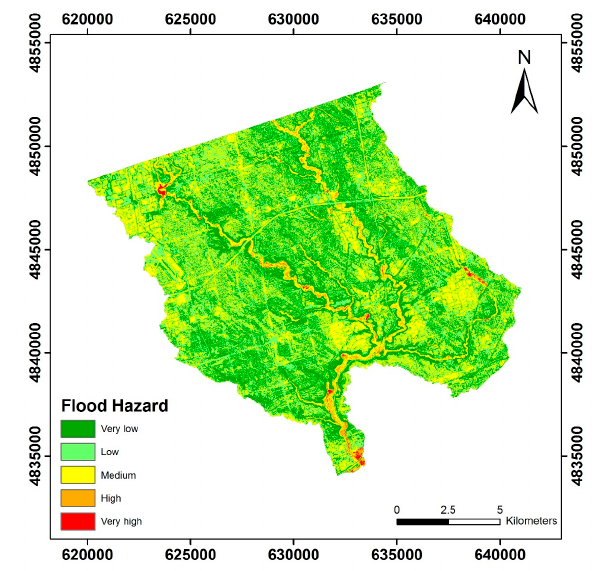
Figure 6. Total flood hazard map.